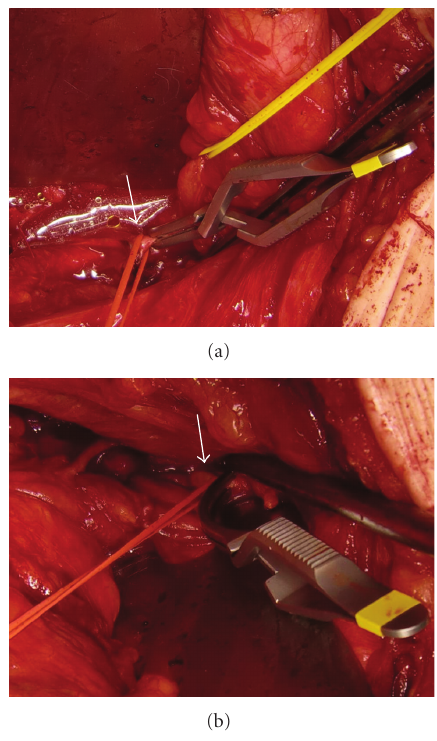
Figure 2: Photograph showing occlusion of bilateral internal iliac arteries by Bulldog clamps. (a) Clamping of right internal iliac artery, (b) Clamping of left internal iliac artery (white